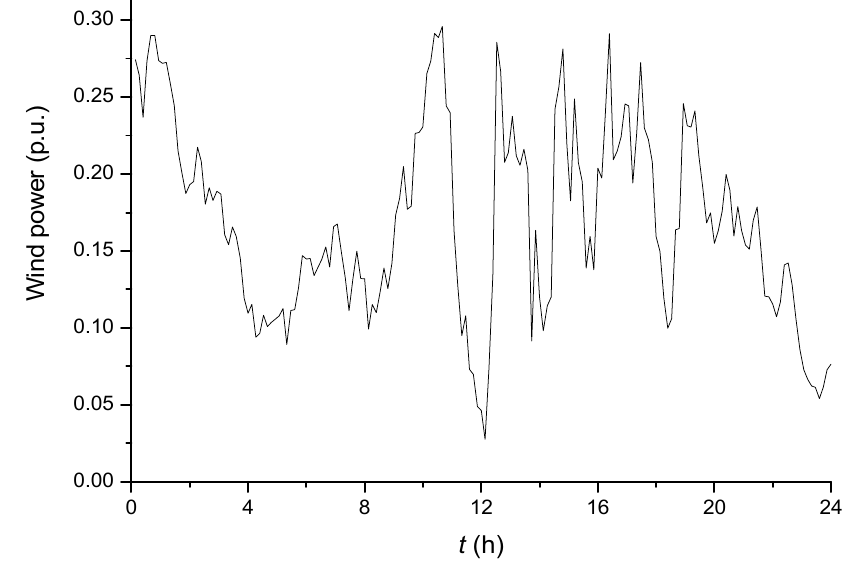
Figure 3. Wind power over the course of a day.